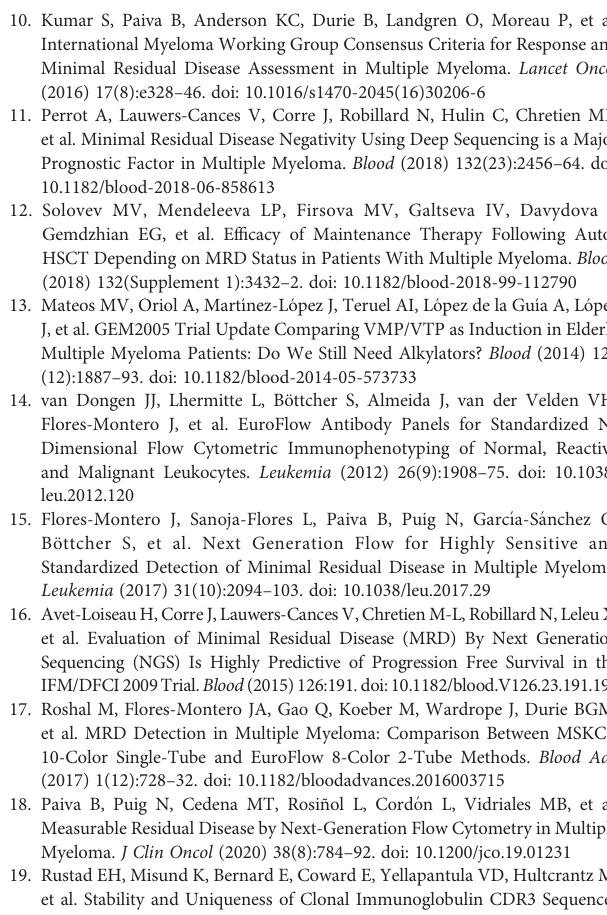
Table 4 summarizes the current limitations of MRD in clinical decision-making and highlights some potential issues